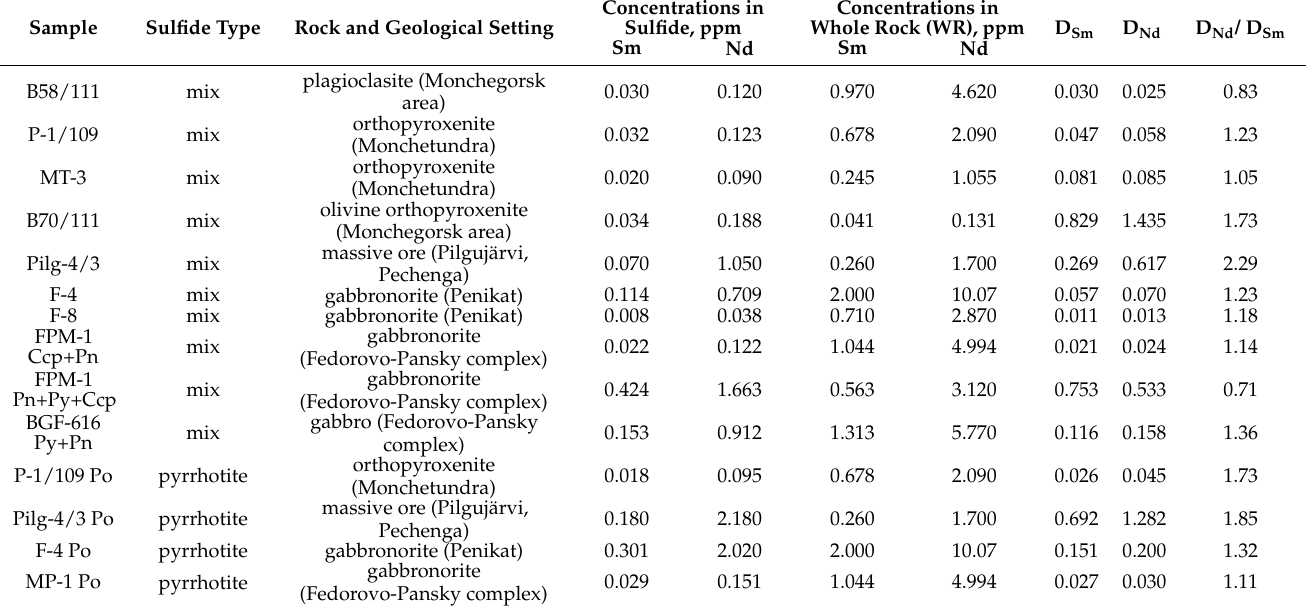
Table 1. Results of analytical Sm-Nd research of sulfide minerals from mafic–ultramafic complexes of the Fennoscandian Shield and calculated sulfide/rock partition coefficients for Nd and